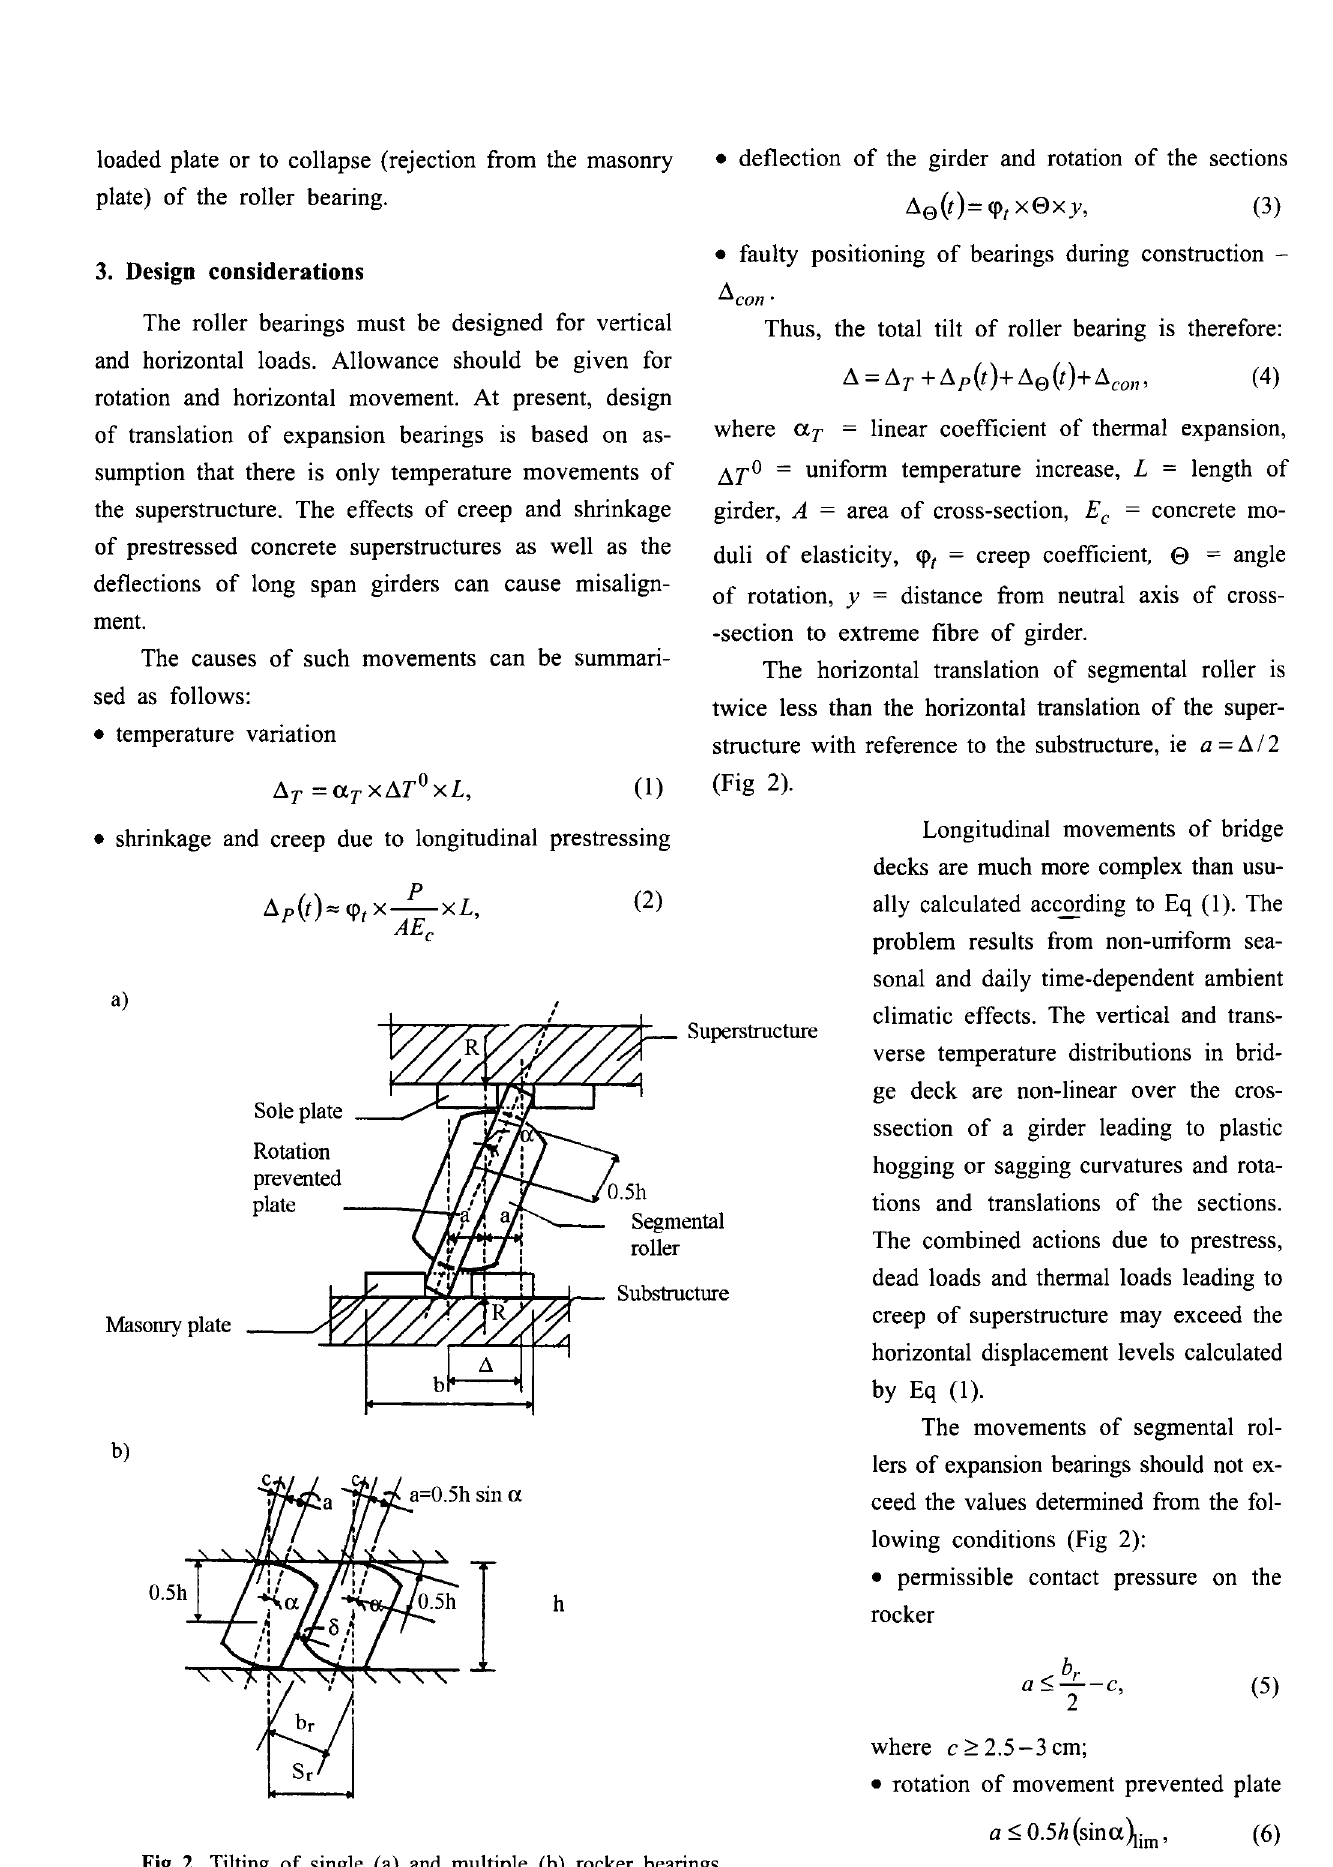
Fig 2. Tilting of single (a) and multiple (b) rocker bearings